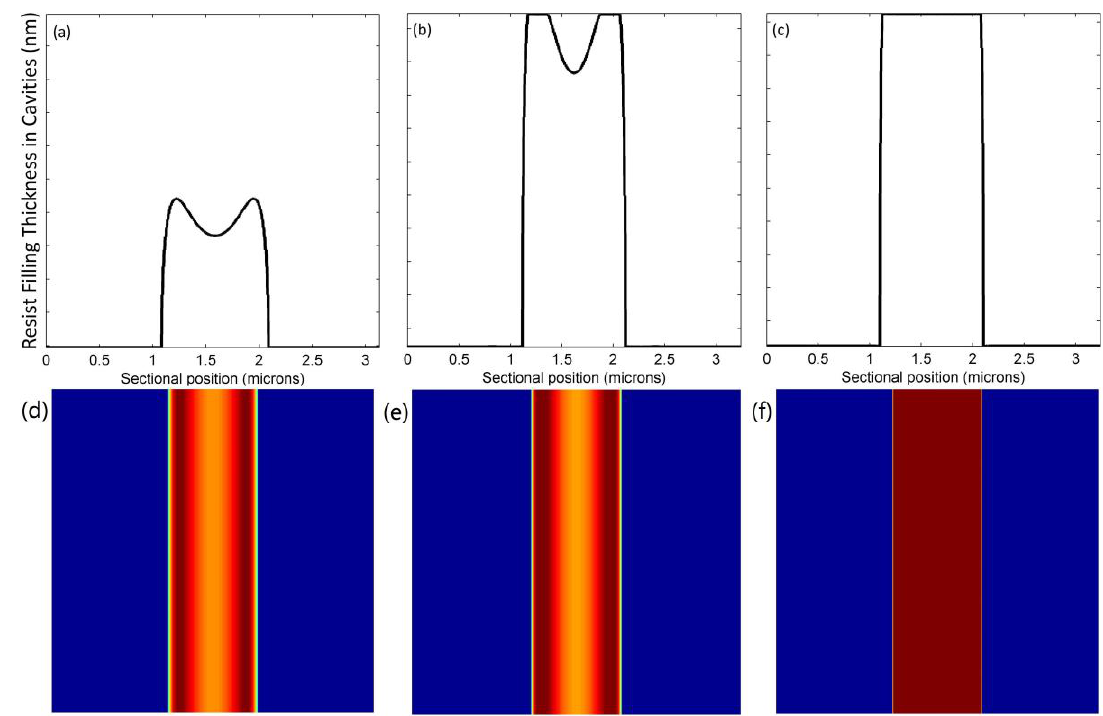
Figure 4. Profiles of resist filling in the microscale cavity at ( a ) 1.08 s; ( b ) 4.32 s; ( c ) 10.80 s and their corresponding top views at ( d ) 1.08 s; ( e ) 4.32 s; ( f ) 10.80 s. Micromachines 2018 , 9 , x FOR PEER REVIEW